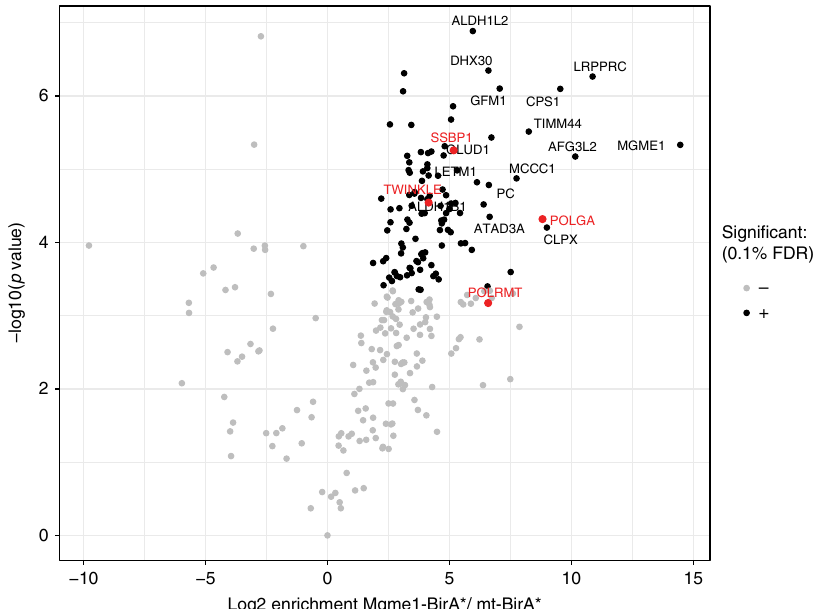
Fig. 6 MGME1 interacts with components of the mtDNA replication machinery. Volcano plot showing proteins enriched after streptavidin pull-down performed in HeLa cells transfected with MGME1-BirA* upon biotin treatment. Mitochondrial targeted BirA* (mt-BirA*) was used as a control. Enriched mtDNA replication factors are highlighted in red. Gray dots nonsigni fi cant, black and red dots signi fi cant hits. Student ’ s t -test with adjusted P -value (Benjamini – Hochberg false discovery rate-FDR correction of less than